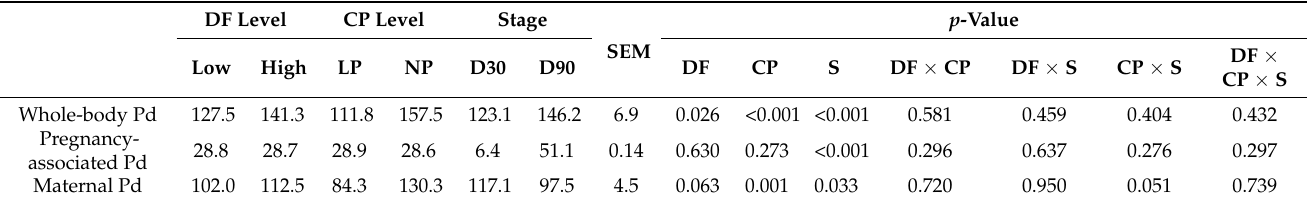
Table 5. Effects of dietary fiber and crude protein levels on protein deposition (g/d) in gestating sows at different gestational